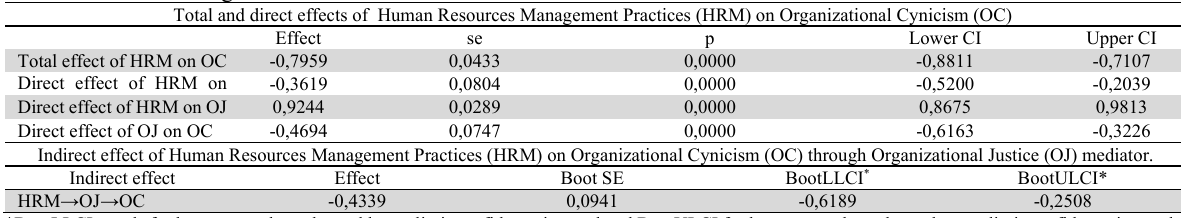
Mediation Effect of Organizational